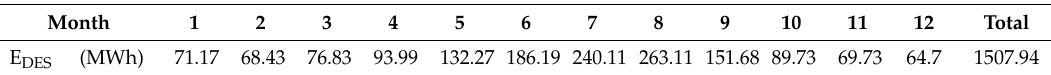
Table 5. Monthly distribution of the energy sent to the desalination plant.